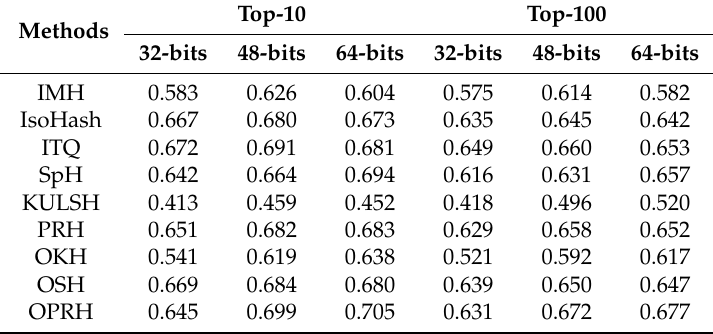
Table 2. The comparison of mean precision of the top K returned examples for different methods on the SAT-6 dataset with varied hash